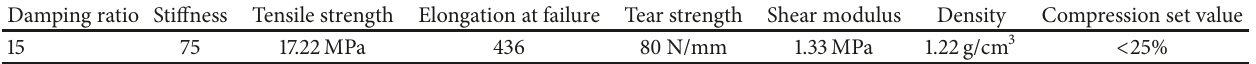
Table 1: Physical and mechanical parameters of high-damping rubber (provided by supplier).